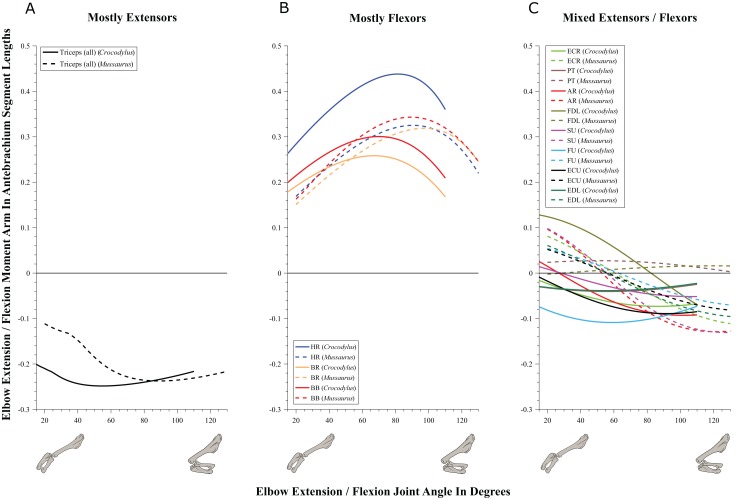
Extension/flexion moment arms around the elbow joint, normalized to radius-ulna segment length, plotted against extension/flexion joint angles for Crocodylus and Mussaurus in the resting pose.(A) Mostly extensors; (B) mostly flexors; (C) mixed extensors/flexors. Negative moment arms correspond to extension, while positive values correspond to flexion. Zero elbow angle corresponds to full extension, while larger angles correspond to flexion. For muscle abbreviations see Table 1.